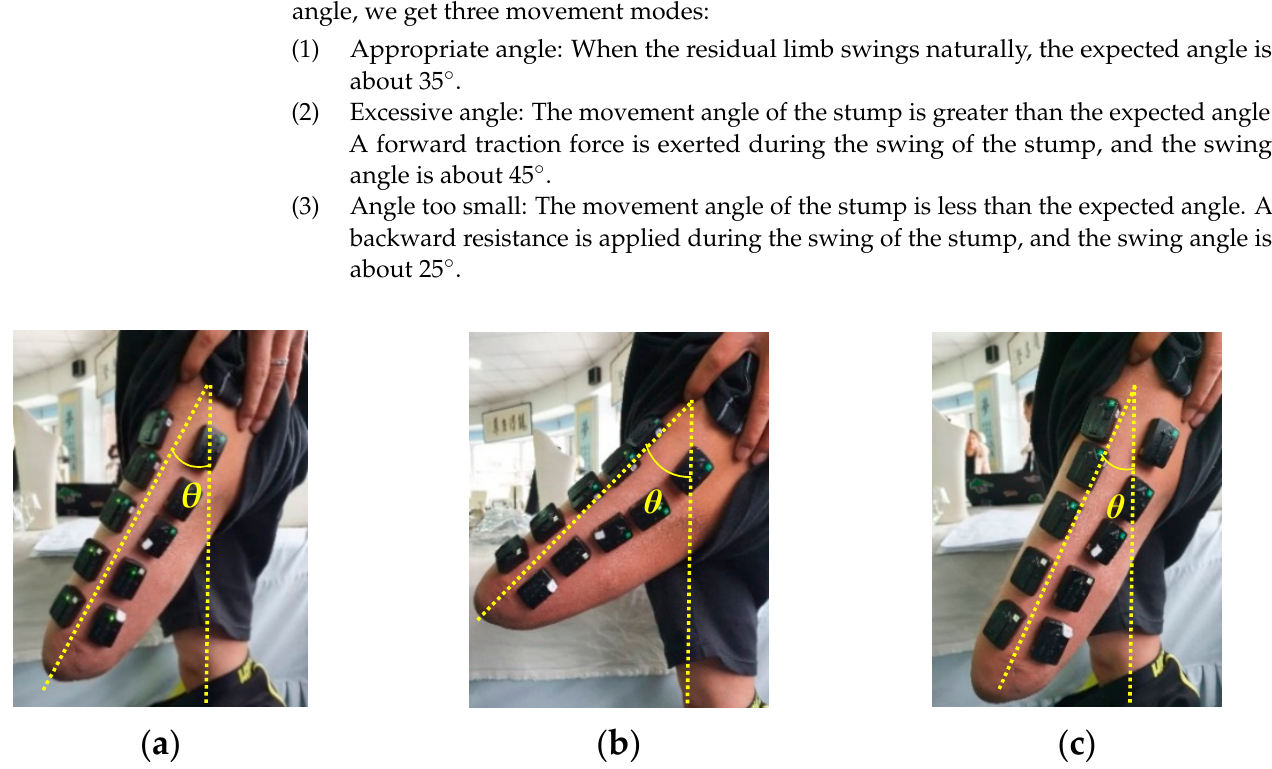
Figure 4. Simulated exercise experiment of the residual limb by the rehabilitation robot. 2.2. Functional Network Construction The key to abstract the residual muscle group system into a network is to clarify the connection relationship between the nodes and analyze the correlation between the two channels by using mutual information [32]. Two EMG channels 𝑆 and 𝑄 are defined. The EMG data of channel 𝑆 is 𝑠 (cid:2869) , 𝑠 (cid:2870) …, 𝑠 (cid:3041) , and the probability distribution is 𝑃 (cid:3046) (cid:4666)𝑠 (cid:2869) (cid:4667) ,